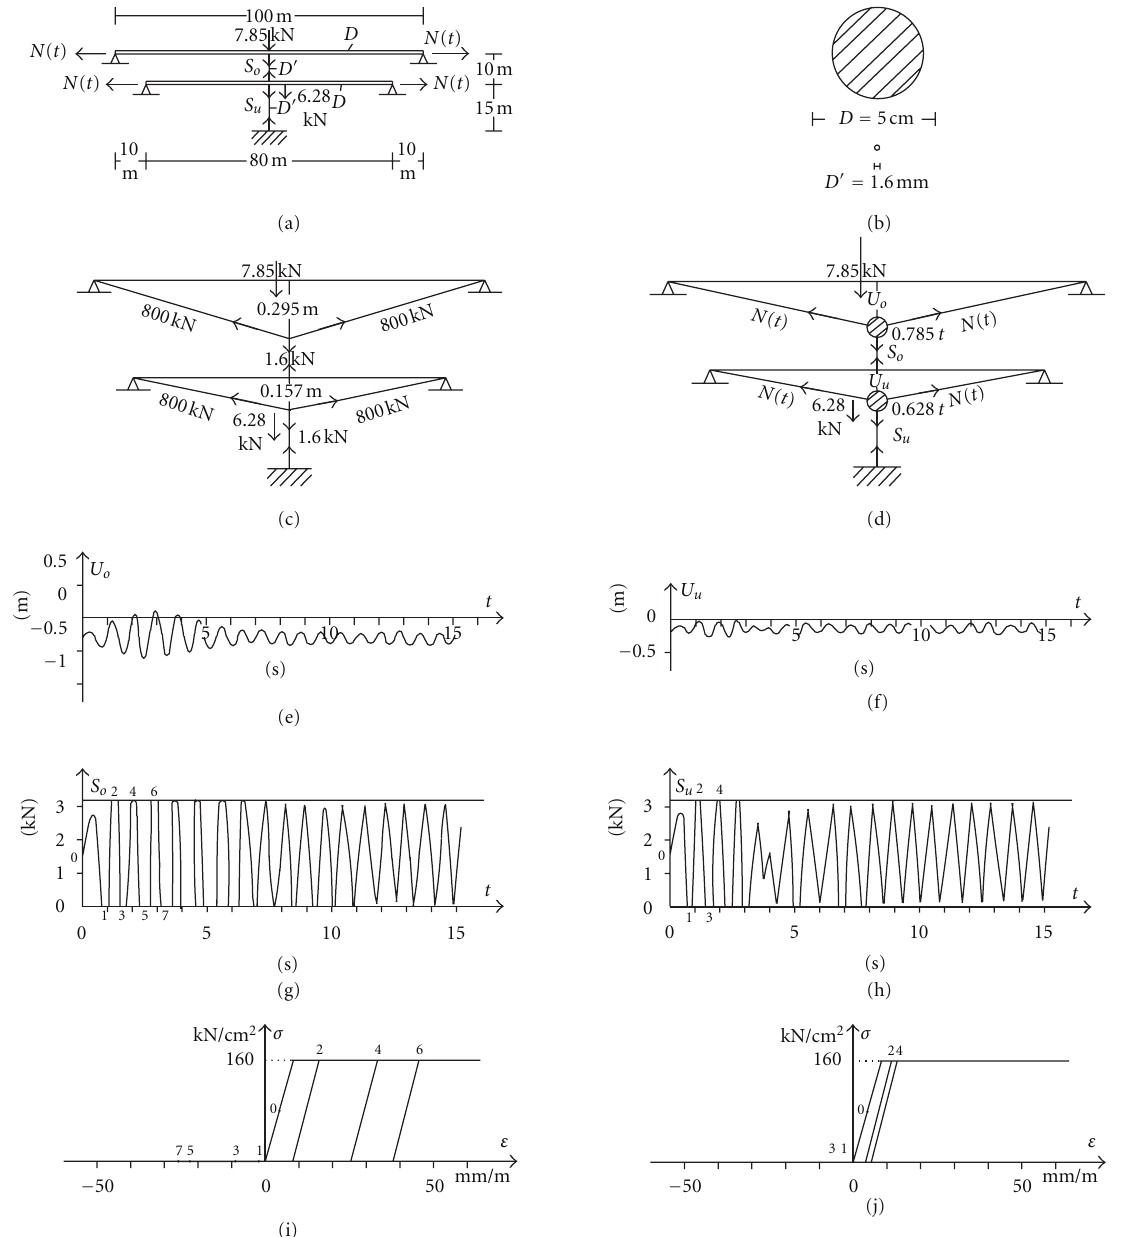
Figure 5: Third application: couple of cables, connected to each other and to deck, subject to tra ffi c. (a) Given geometry and loading. (b) Cross sections of main cables and cross-ties. c. Initial static analysis. (d) Parameters of dynamic analysis. (e), (f) Resulting time-histories of displacements of upper and lower cables. (g), (h) Resulting time-histories of axial forces of upper and lower cross-tie. (i), (j) Resulting hysteresis stress-strain loops of upper and lower